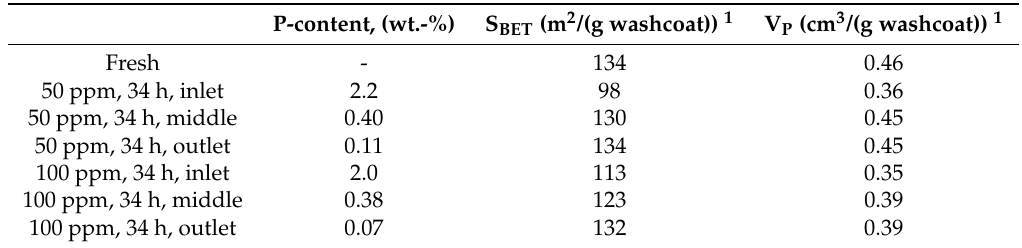
Table 2. Phosphorous content, specific surface area and pore volume of the fresh Pt/Ba/Al 2 O 3 sample and of the Pt/Ba/Al 2 O 3 samples exposed to 50 and 100 vol.-ppm phosphorous for 34 h. The phosphorus contents are measured by inductive coupled plasma atomic emission spectroscopy (ICP-AES).